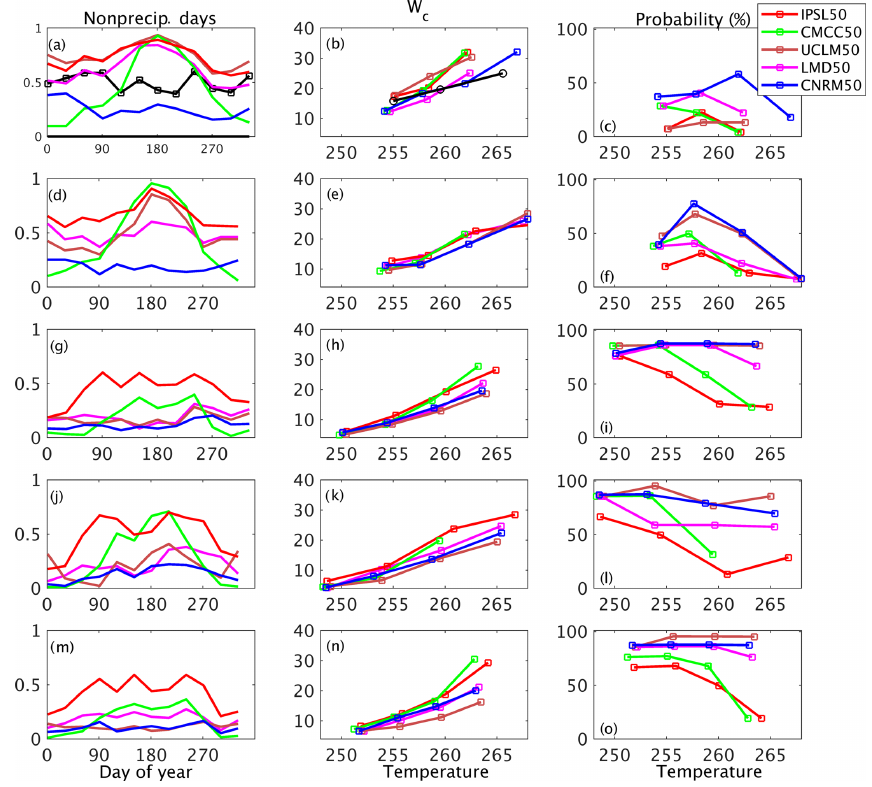
Figure 9. (a, d, g, j, m) Annual cycle of occurrence of nonprecipitating days for the different models and COMEPHORE in black in panel (a) (same legend as Fig. 8 for models). (b, e, h, k, n) Value of w c (maximum value) as a function of tropospheric temperature. (c, f, i, l, o) Probability of exceeding w c value. First row is for the station located in southern France (Marseille), second row for the one located in central Spain (Madrid), third row for the station in eastern Germany (Dresden), fourth row in Ukraine, and fifth row in the Netherlands (see Table 8 and Fig. 1 for details on the locations of the